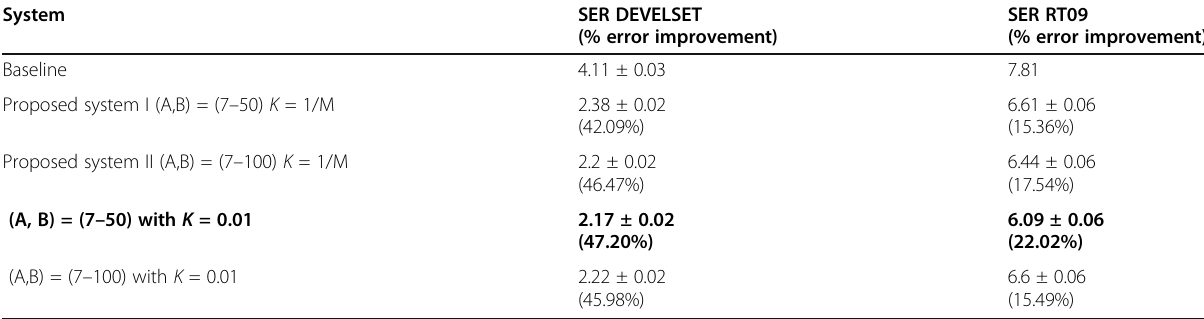
Table 8 Overall results for the develset and the RT09 set for different alternatives